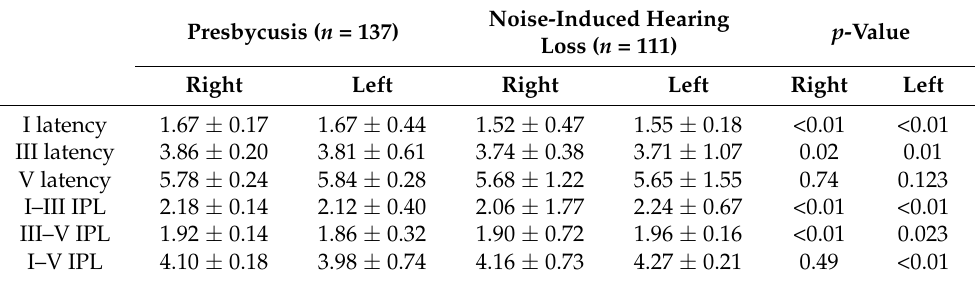
Table 4. ABR results in patients with presbycusis and noise-induced hearing loss. Noise-Induced Hearing p -Value Presbycusis ( n = 137) Loss ( n = 111) Right Left Right Left Right